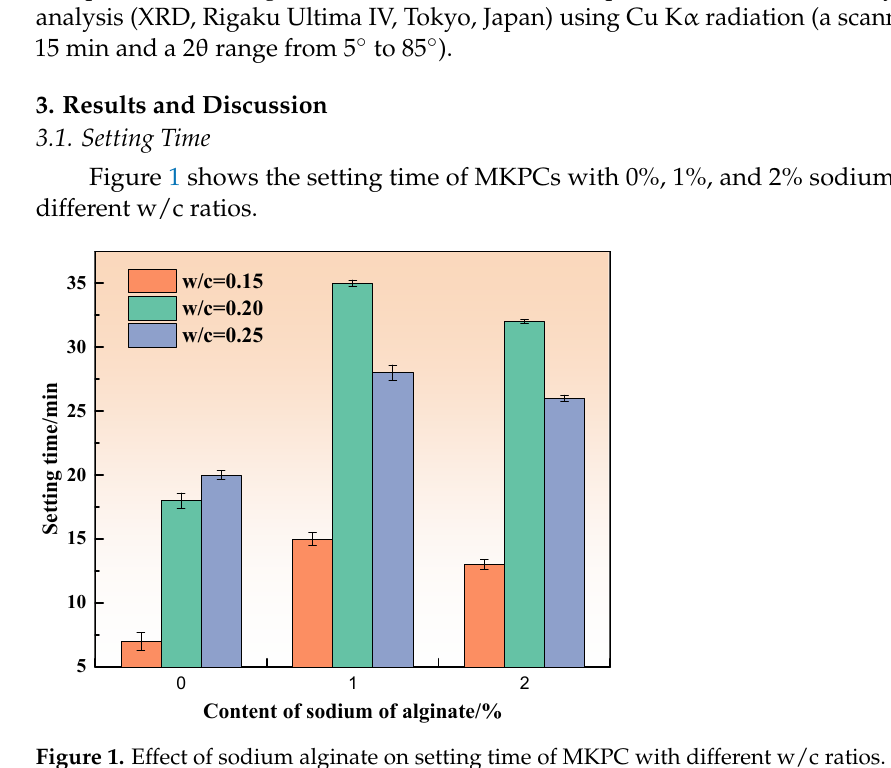
Figure 1. Effect of sodium alginate on setting time of MKPC with different w/c ratios.